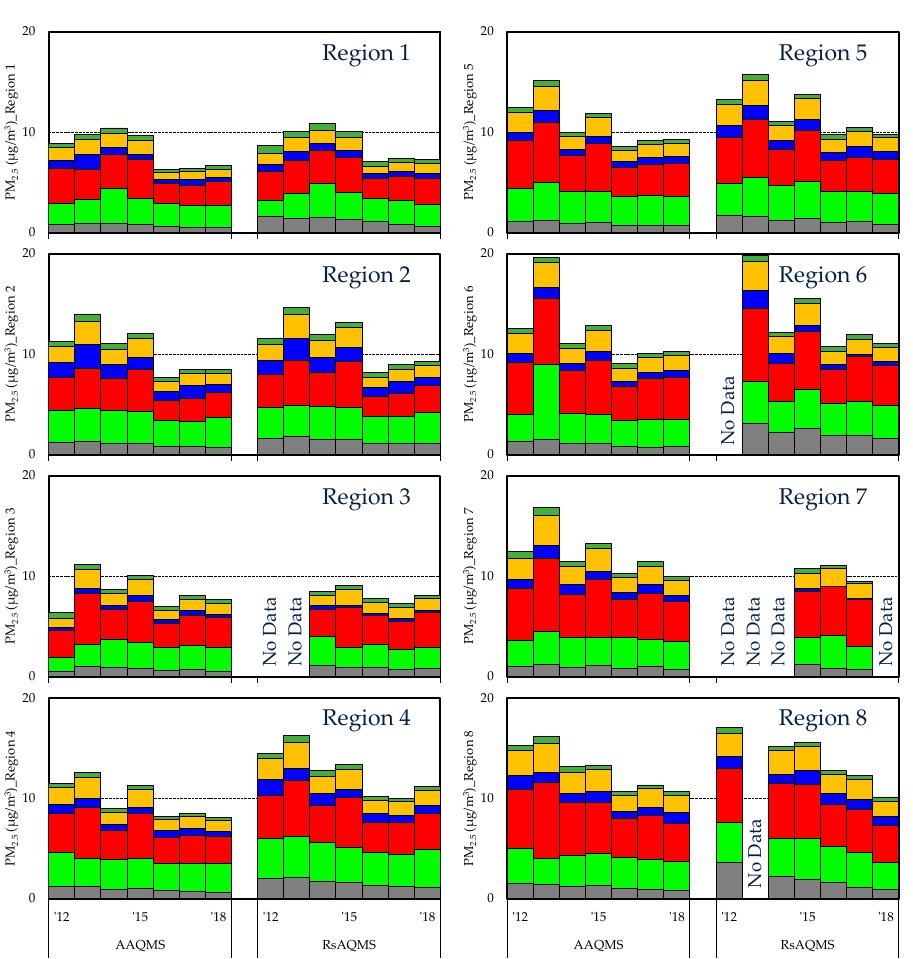
Figure 4. Annual mean concentrations of PM 2.5 components at AAQMS and RsAQMS by region (left: region 1 to 4 from the top, right: region 5 to 8 from the top).